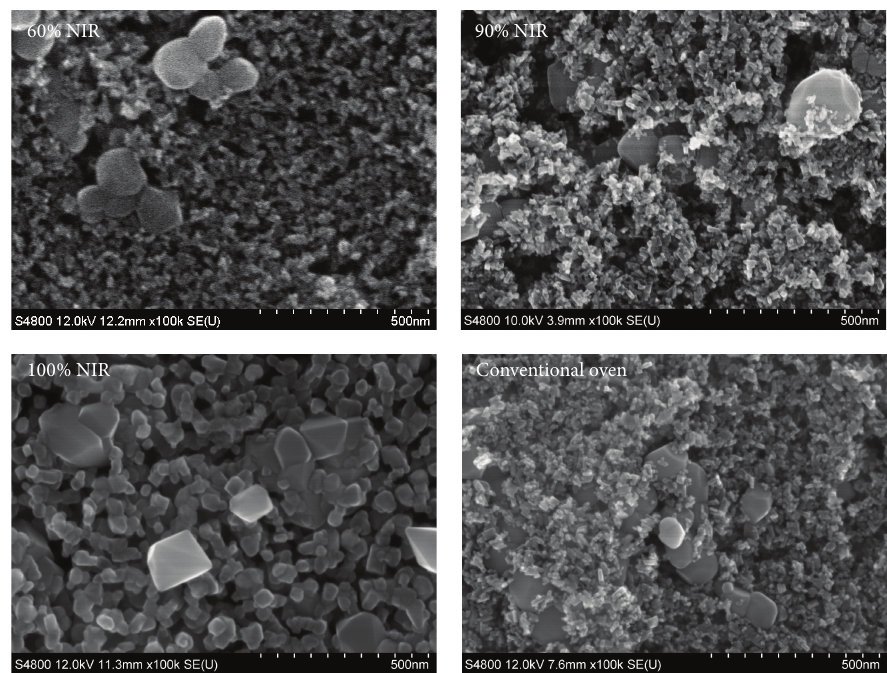
Figure 4: SEM micrographs of TiO 2 films on FTO glass heated with 12.5 s of NIR radiation at 60%, 90%, and 100% as well as a conventionally sintered